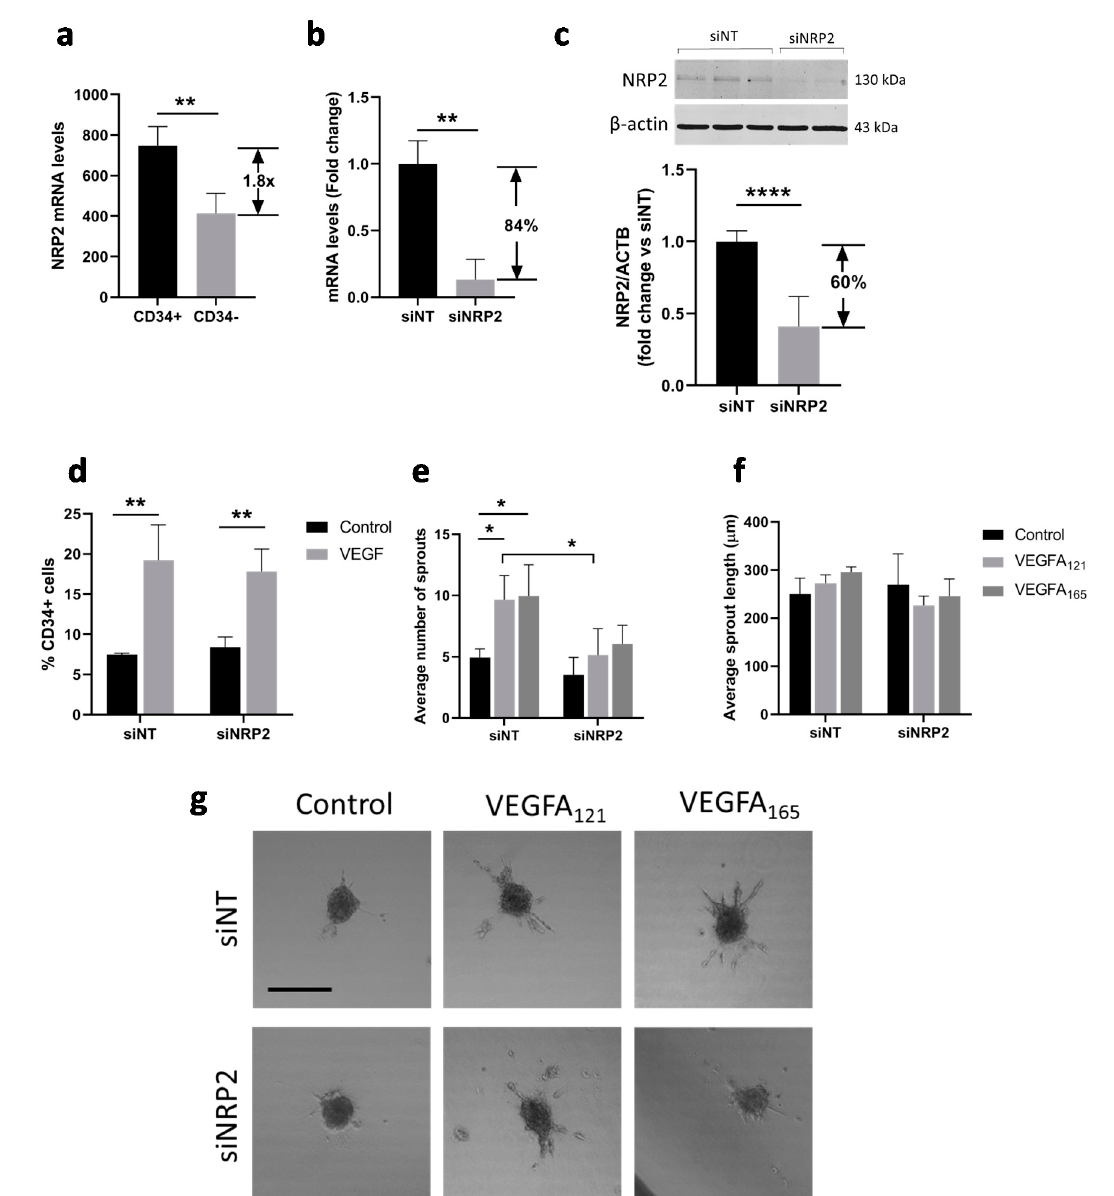
Figure 3. Effect of NRP2 knockdown on VEGF-induced tip cell formation and sprouting. ( a ) Microarray analysis showed enrichment of NRP2 mRNA in CD34 + cells as compared to CD34 - cells. HUVECs were cultured in the presence or absence of VEGFA 121 and/or VEGFA 165 or after treatment with siNT or si NRP2 ; ( b ) Treatment of cells with si NRP2 resulted in a significant reduction in mRNA levels of 84% as compared to treatment with siNT; ( c ) Treatment of cells with si NRP2 resulted in a significant reduction in protein levels of 60% as compared to treatment with siNT. A representative western blot is shown. Quantification of NRP2 levels as compared to β -actin levels is shown below in three HUVEC donors; ( d ) Flow cytometric analysis of CD34 + cells (% of total number of cells). Average number ( e ) and length in µm ( f ) of sprouts per HUVEC spheroid; ( g ) Representative images of sprout formation from HUVEC spheroids. Results are presented as the mean ± standard deviation of three HUVEC donors. Unpaired T-tests ( a , b ) or Two-way ANOVA analyses ( c – e ) were used to calculate statistical differences (* p < 0.05, ** p < 0.01, **** p < 0.0001). Scale bar = 250 µm.